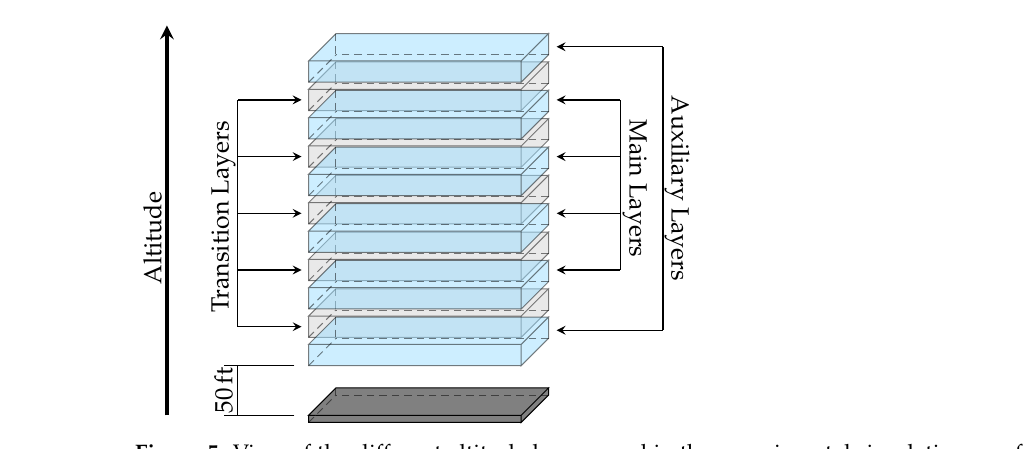
Figure 5. View of the different altitude layers used in the experimental simulations performed in this